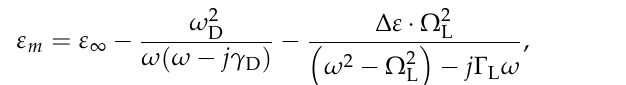
π = 104.86 THz, L /2